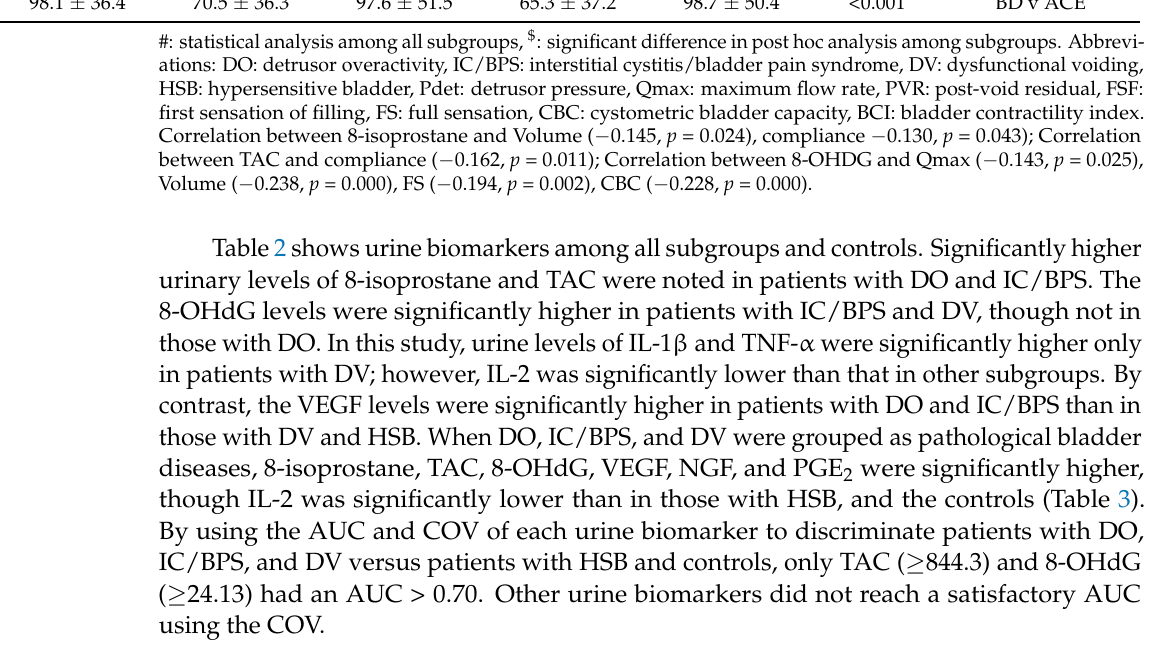
Table 2. Urinary biomarker levels in women with different bladder dysfunctions and normal